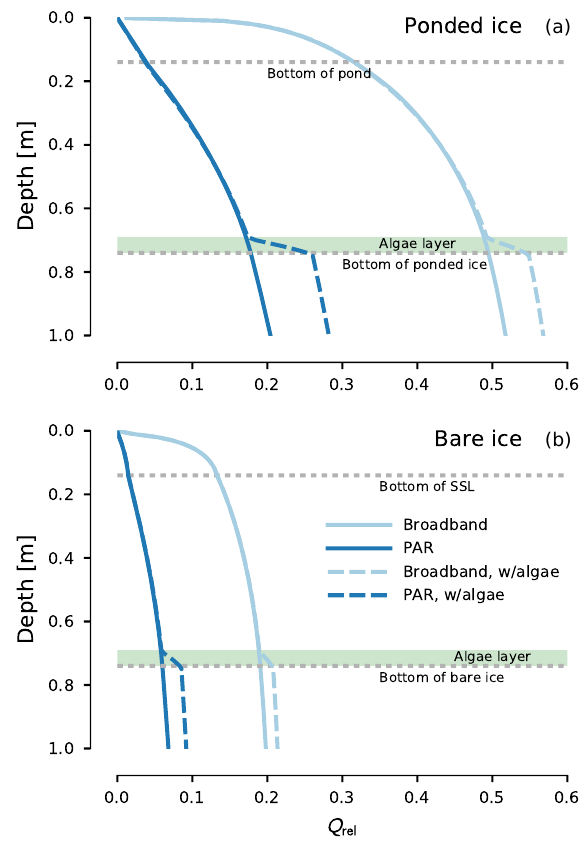
Figure 9. Cumulative heating (Eq. 6) relative to the incident irradi- ance, for (a) ponded ice (Fig. 8a, c), and (b) bare ice (Fig. 8b, d). The green shaded region indicates where chlorophyll a is added for the algae cases. Solid lines are without algae in the lower 5cm, dashed lines are with algae. Darker lines are for the PAR range and lighter coloured lines for broadband